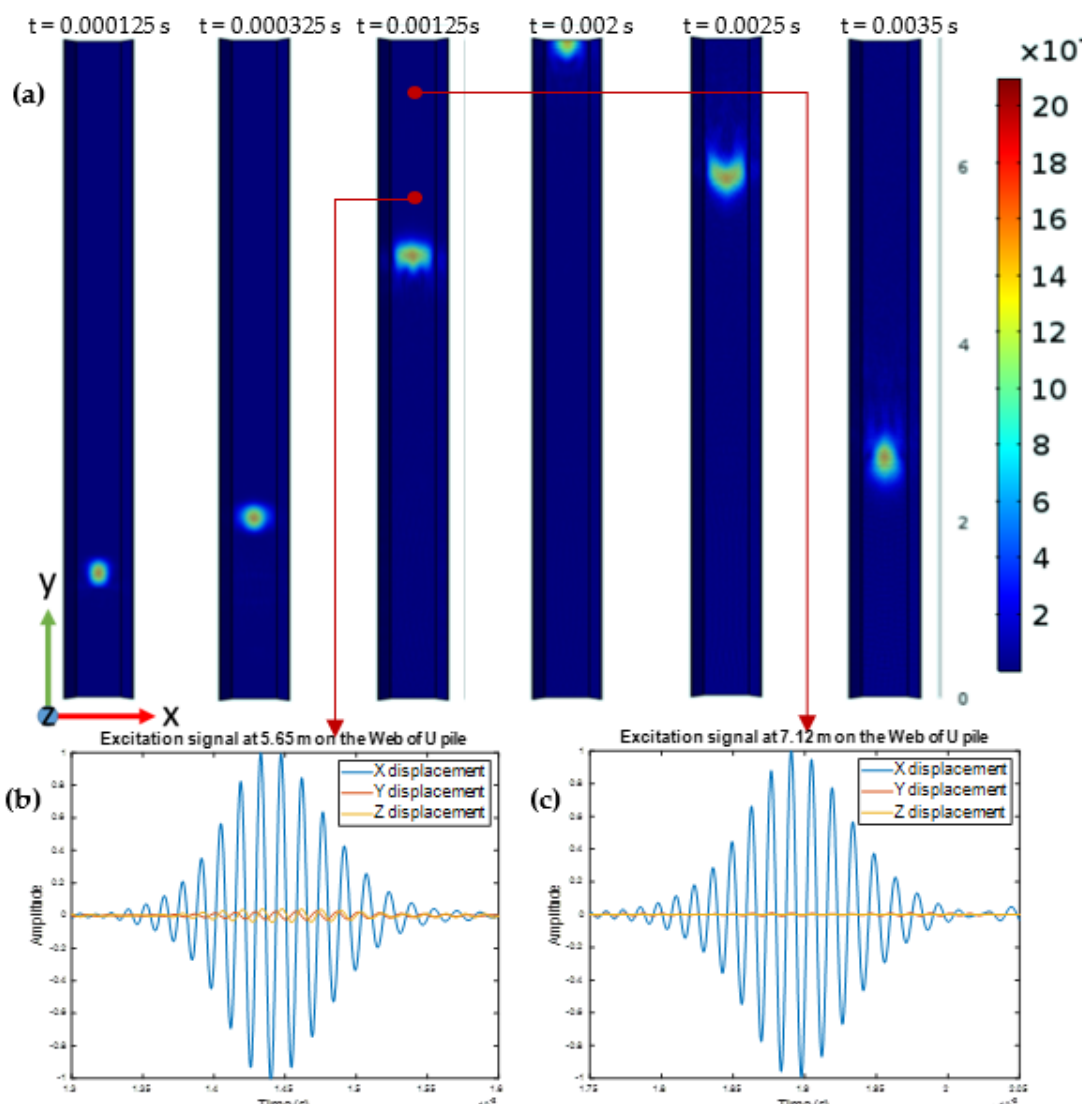
Figure 12. ( a ) Shear wave propagation in the web of the U-pile, ( b , c ) the excitation signal when it reached the distance of 5.65 m and 7.12 m, respectively.